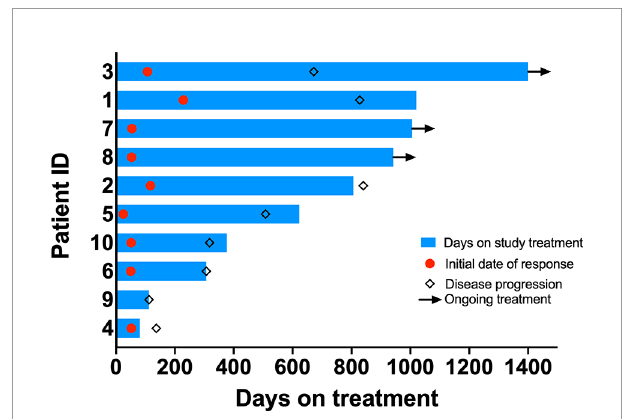
FIGURE 2 | Swimmer ’ s plots. Bar length indicates duration of treatment. Red circle indicates time when response was observed. Diamond indicates time when progression was noted. Arrowheads indicate ongoing study treatment.